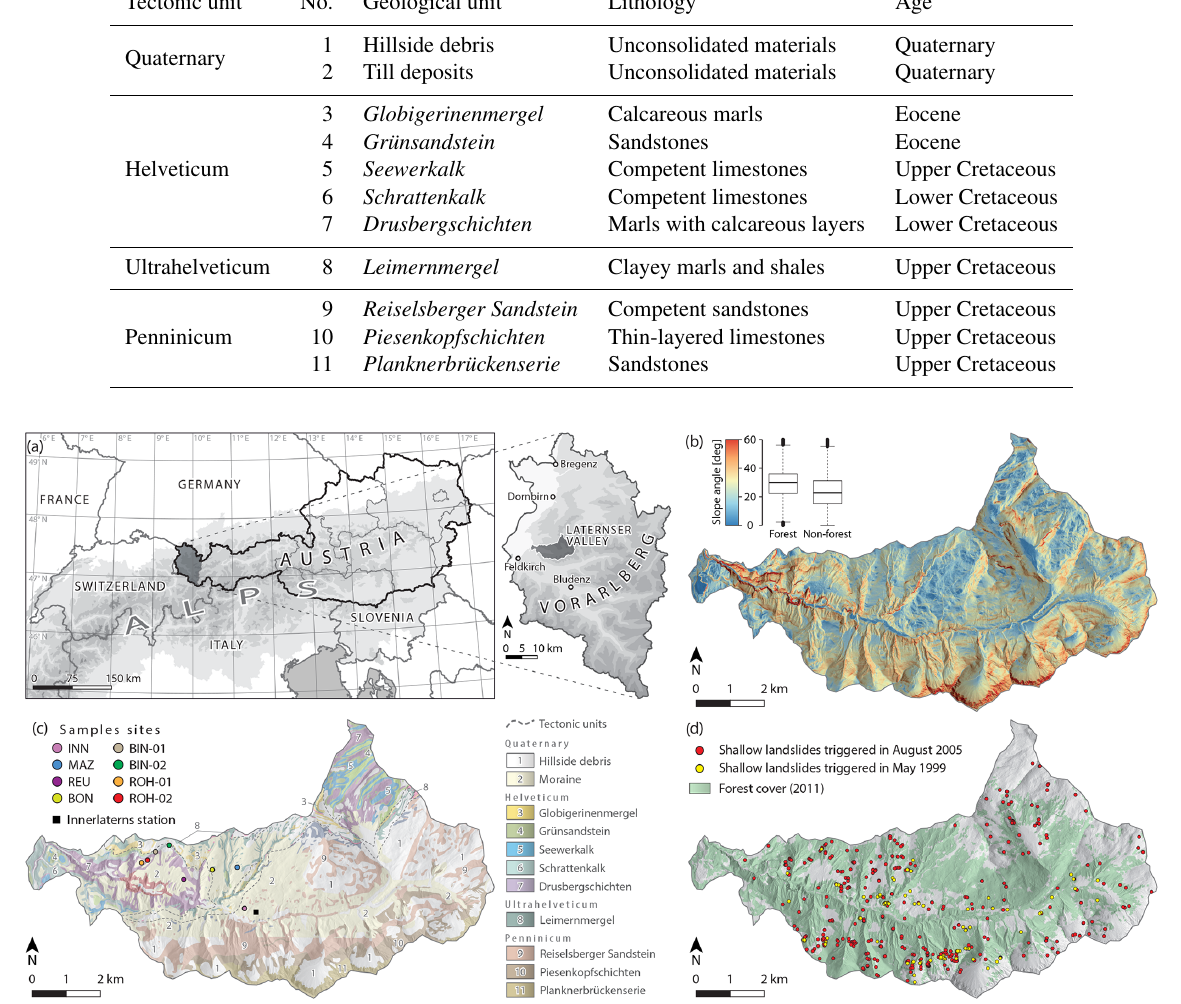
Figure 2. Location of the Laternser valley (a) , slope angle map (b) , geological map with sampled sites (c) and shallow landslide inventory (d) . The slope angle map is based on a digital terrain model derived from airborne laser scanning (ALS) in 2011, serving as input data for modelling (resampled to a spatial resolution of 10m). The box plots show the slope angle distribution for forest and non-forest areas. In the geological map only geological units covering more than 1% of the catchment area are listed in the legend (data source: Heissel et al., 1967; Oberhauser, 1982). The shallow landslide inventory shows landslides triggered by the rainfall events in May 1999 (82; yellow) and August 2005 (356; red) occurring on undisturbed hillside slopes (Zieher et al., 2016). The areas covered by forest were derived from ALS data acquired in